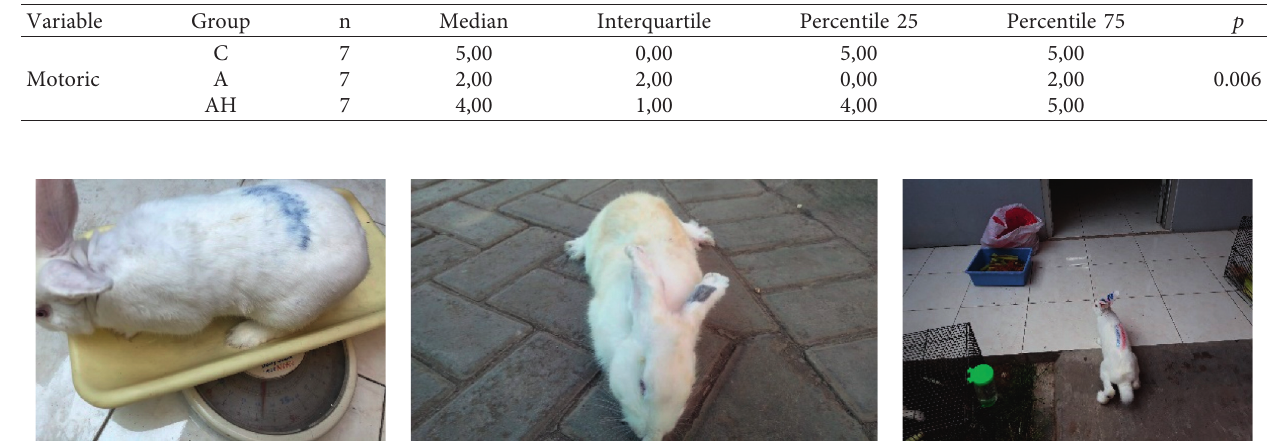
Table 1: Descriptive data of motoric scale of the rabbit model.